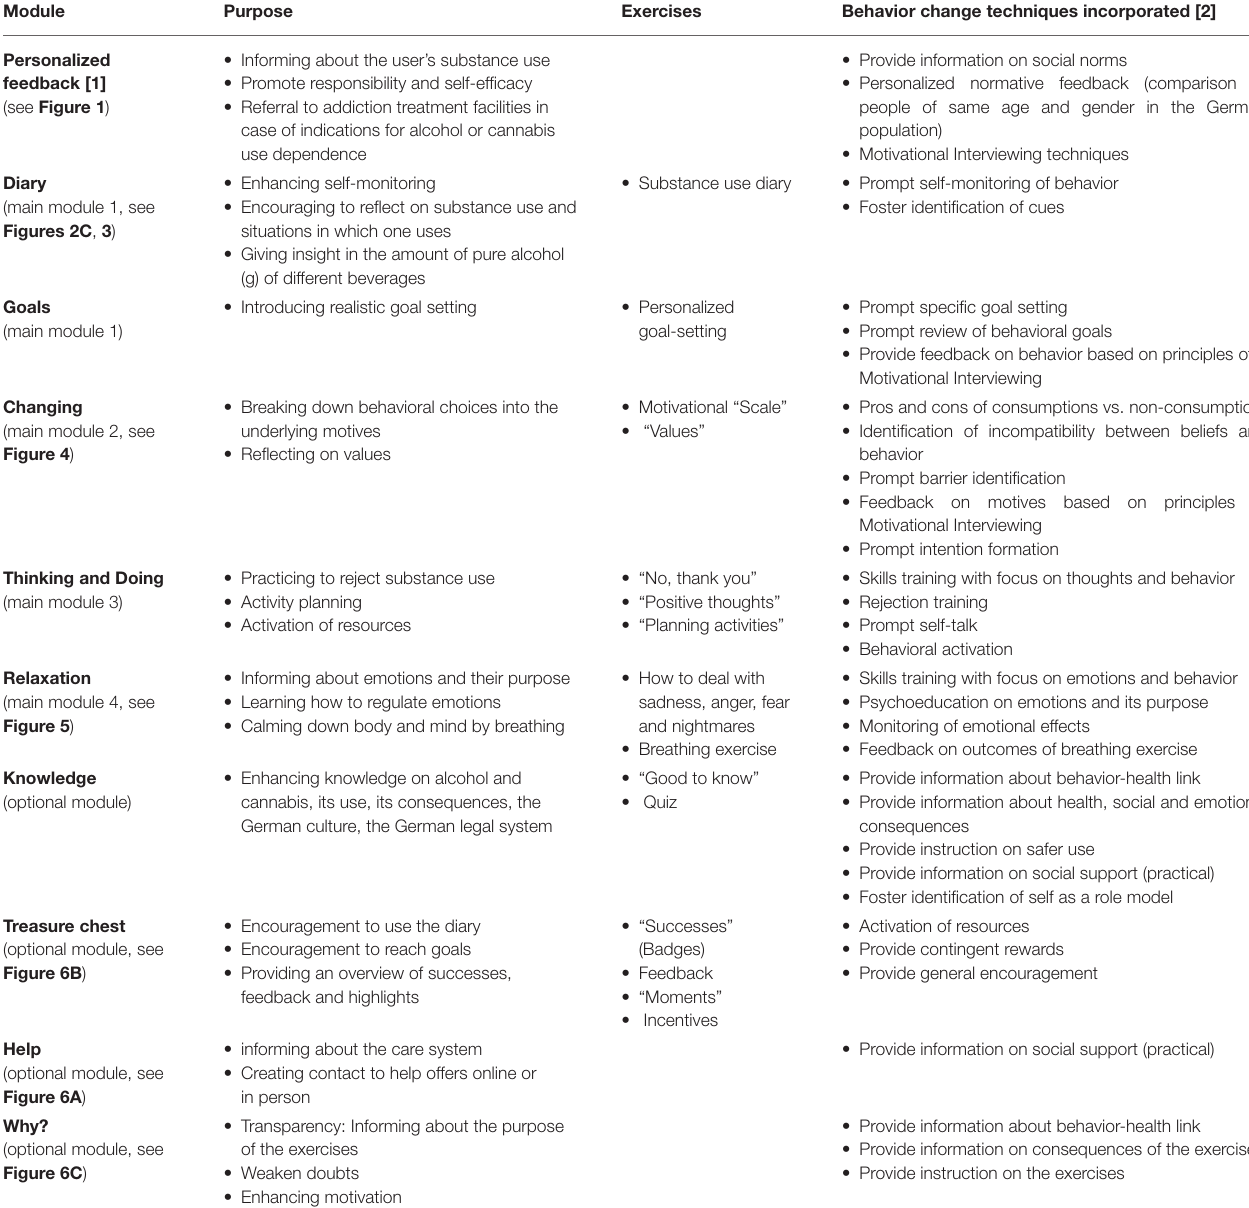
TABLE 1 | Content of the digital